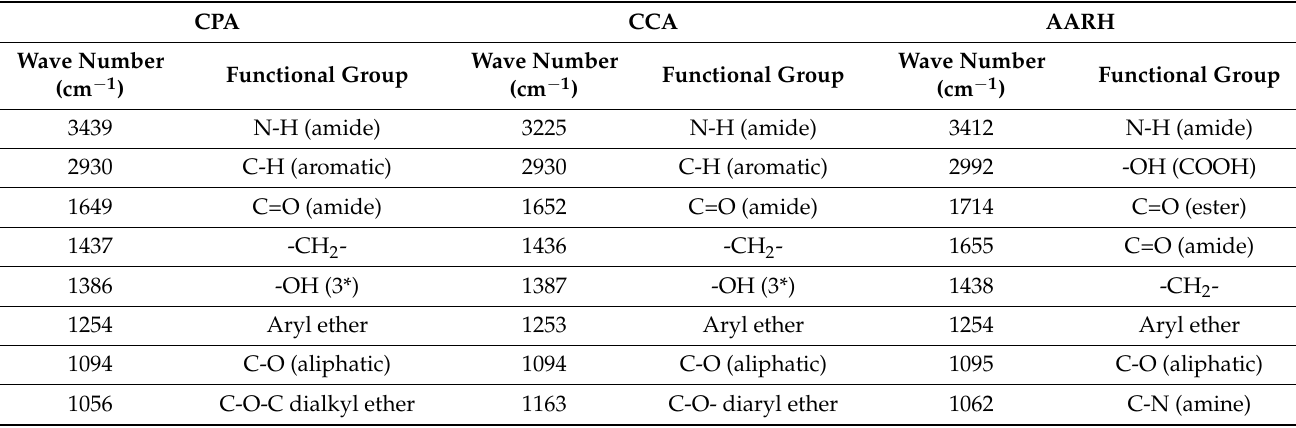
Table 3. Fundamental IR vibrations of phytochemicals present in the aqueous fraction of C. procera , C. colocynthis, and A. arvensis.